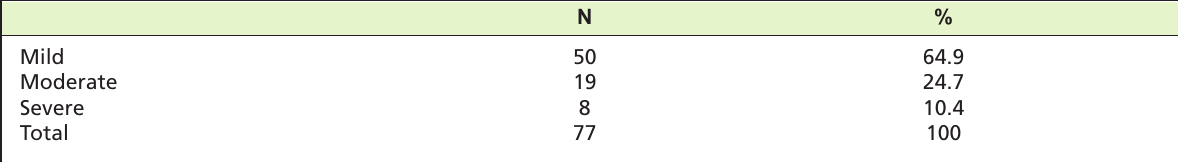
Padua electromyography evaluation Table III: